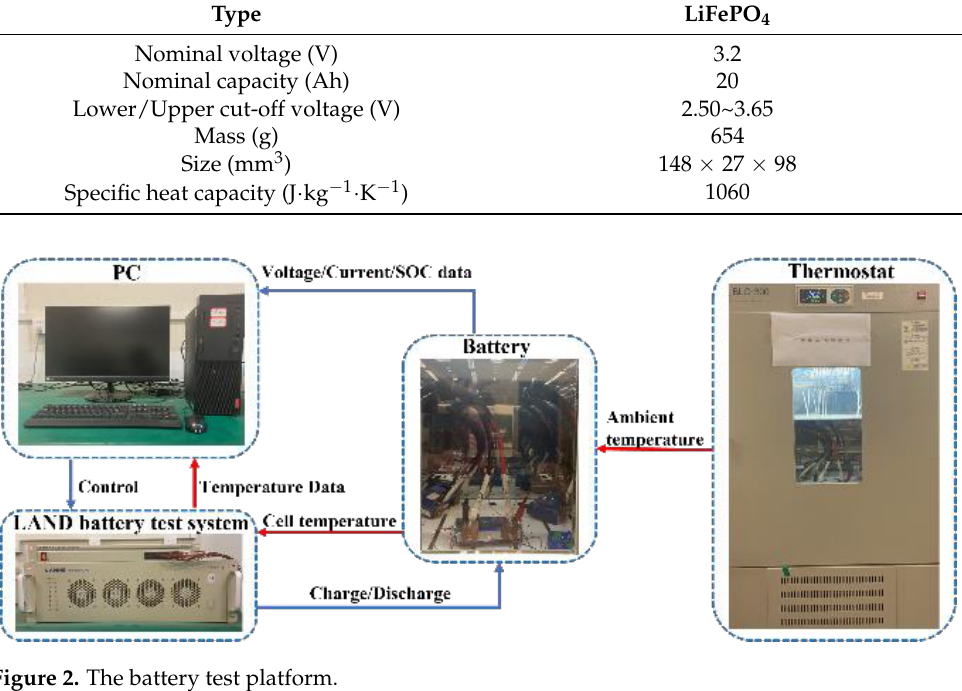
Table 1. Cell parameters.